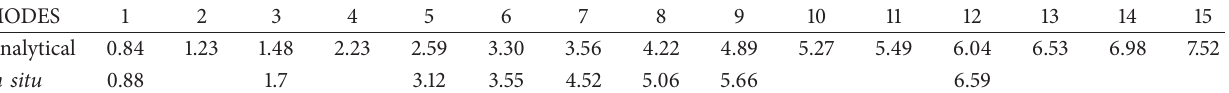
Figure 13: RC structure under study: (a) analytical model; (b) deck cross section; (c) view of column, deck, and stairway. Table 9: Comparison of frequencies (Hz) between the analytical model and measurements in situ .